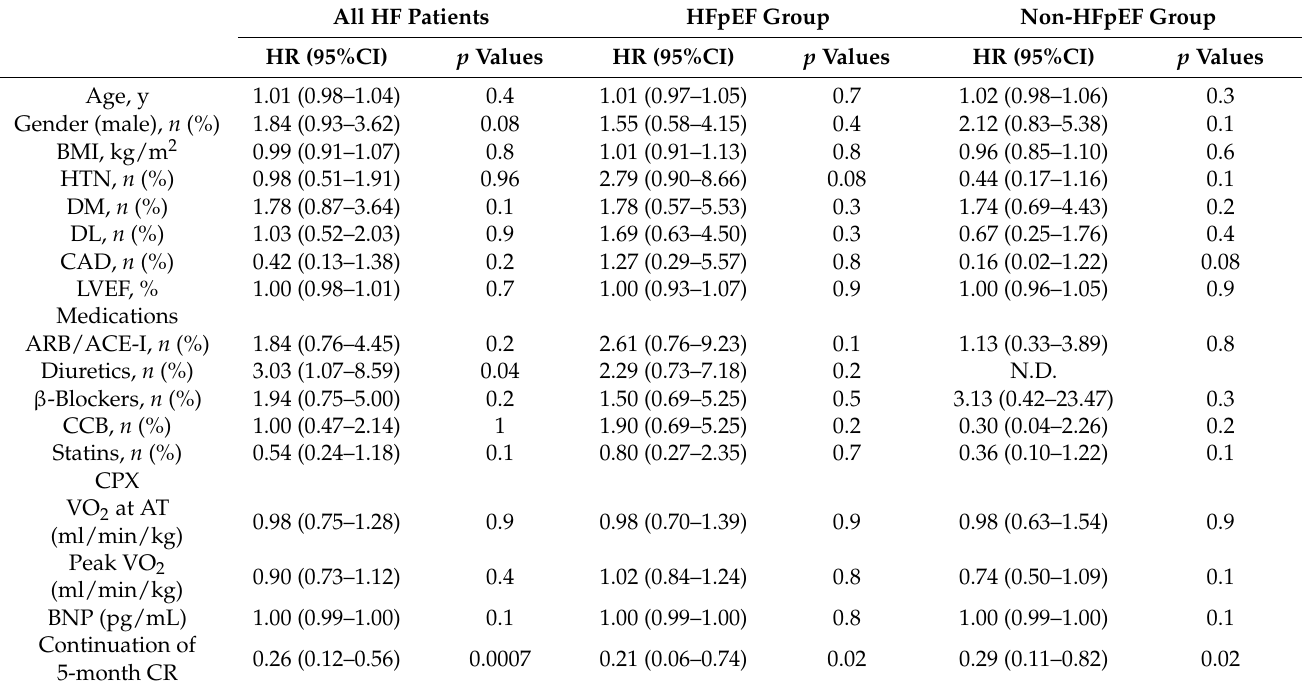
Table 4. The relationship between various parameters and all-cause death and hospital admission analyzed by a Cox regression analysis in all HF patients and HFpEF and non-HFpEF